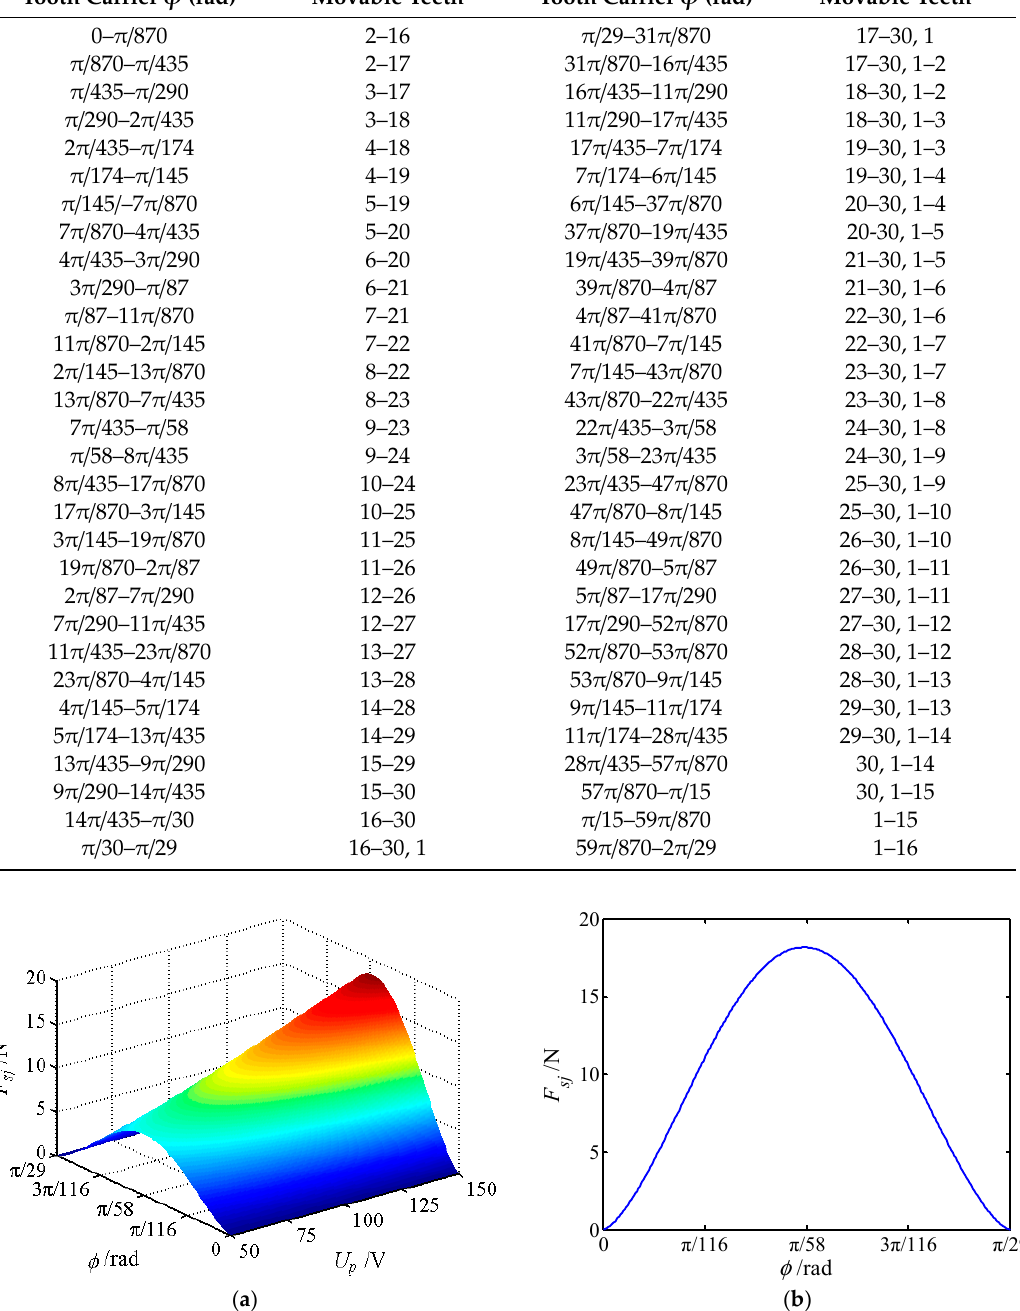
Figure 10. The force of movable tooth F sj . ( a ) The force varies with rotational angle and voltage; ( b ) force sectional view at U p = 150